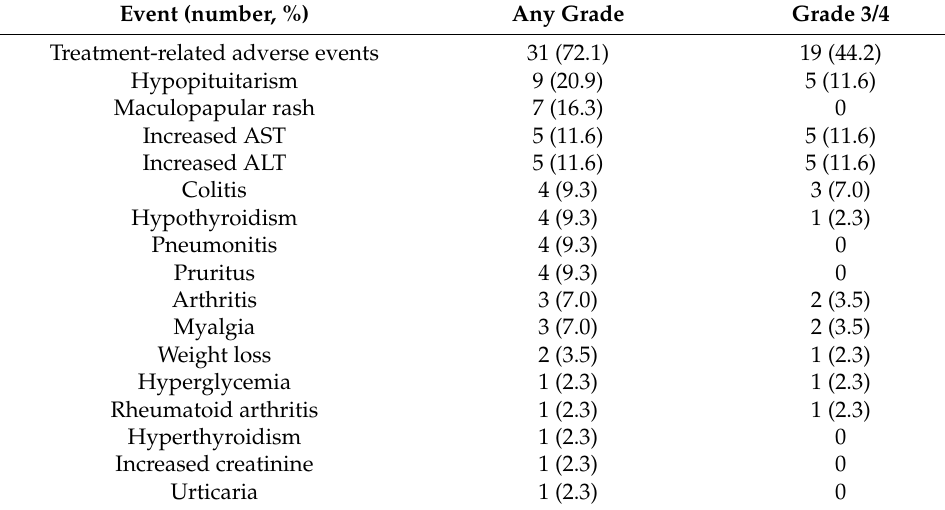
Table 2. Adverse events according to